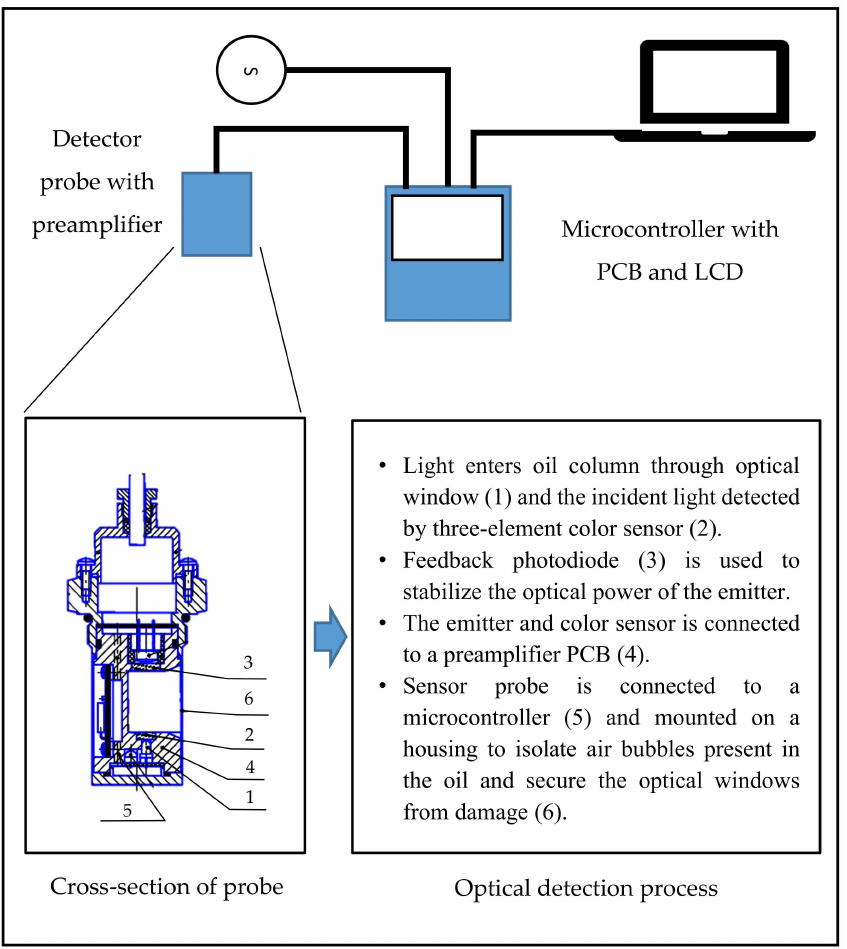
Figure 6. Instrumentation for CR detector